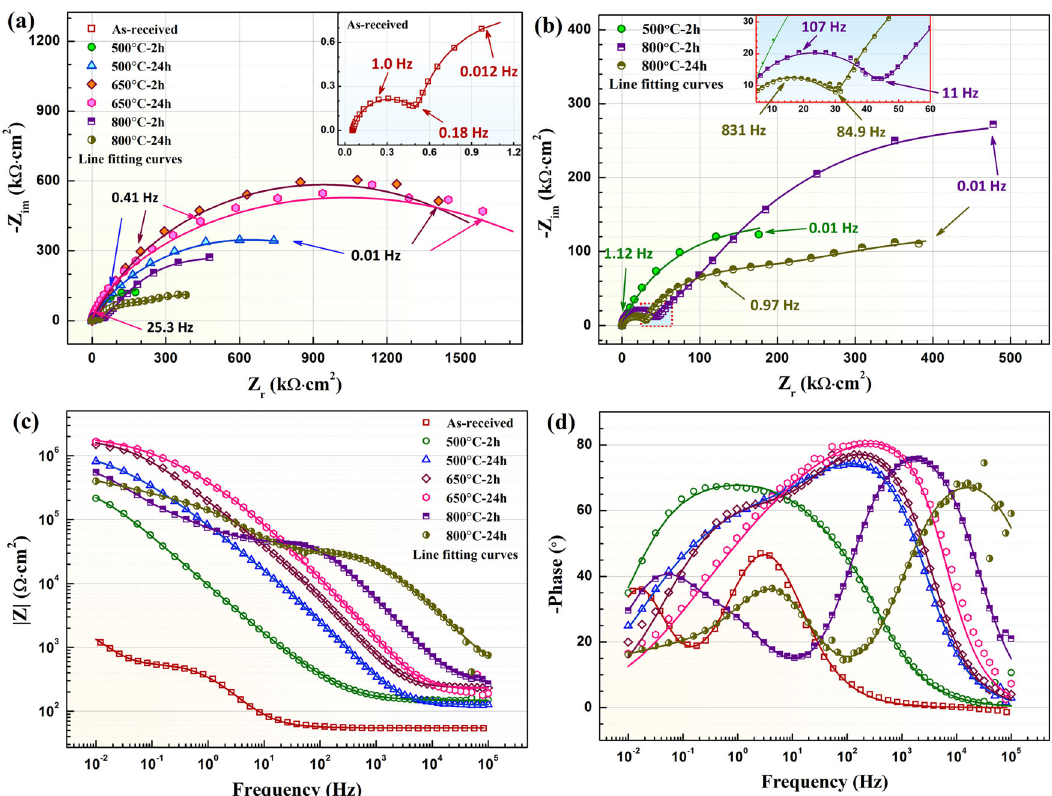
Fig. 5 EIS of the as-received and thermally oxidized pure Ti in the simulated condensates. Nyquist a , b , modulus c , and phase angle d diagrams of the EIS